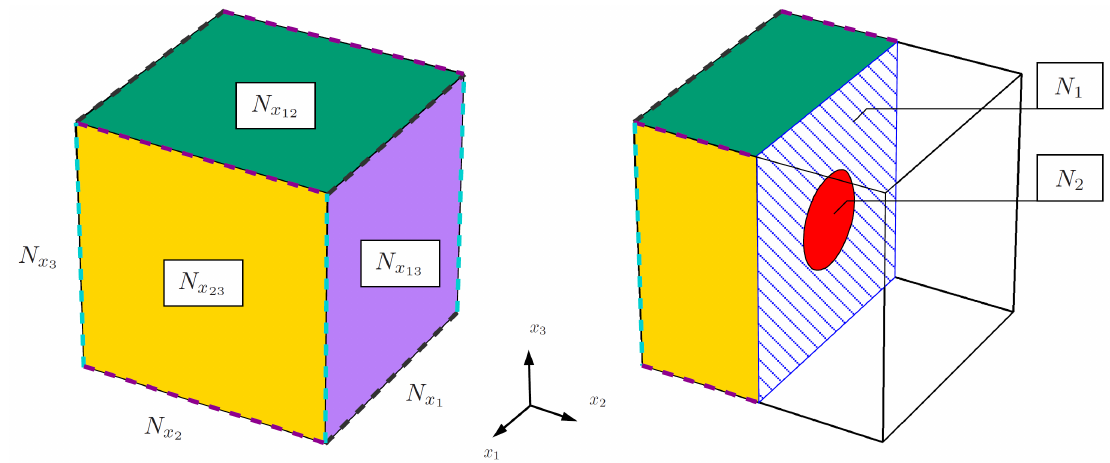
Figure 10. A representation of the artificial neural networks used in the construction of the trial function φ t . There are separate ANNs for the edges, surface boundaries and volumes. In the piecewise-defined approach, there is one additional ANN acting in the